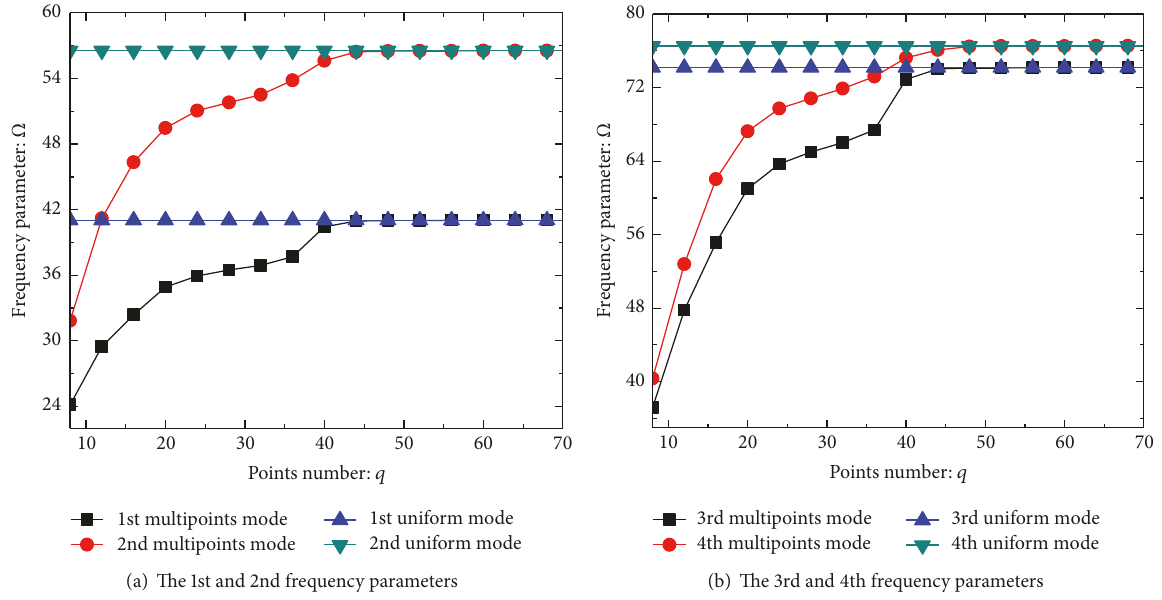
Figure 9: Frequency parameters Ω versus points number 𝑞 for layered plate with multipoints supported boundary